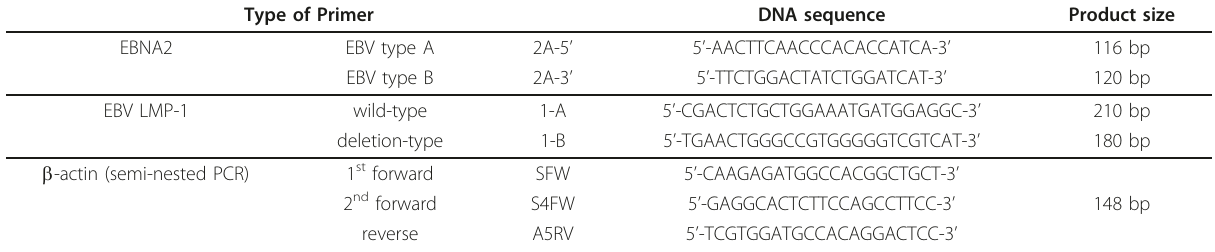
Table 1 List of PCR primers used for EBV subtyping and detection of LMP1 gene deletion Type of